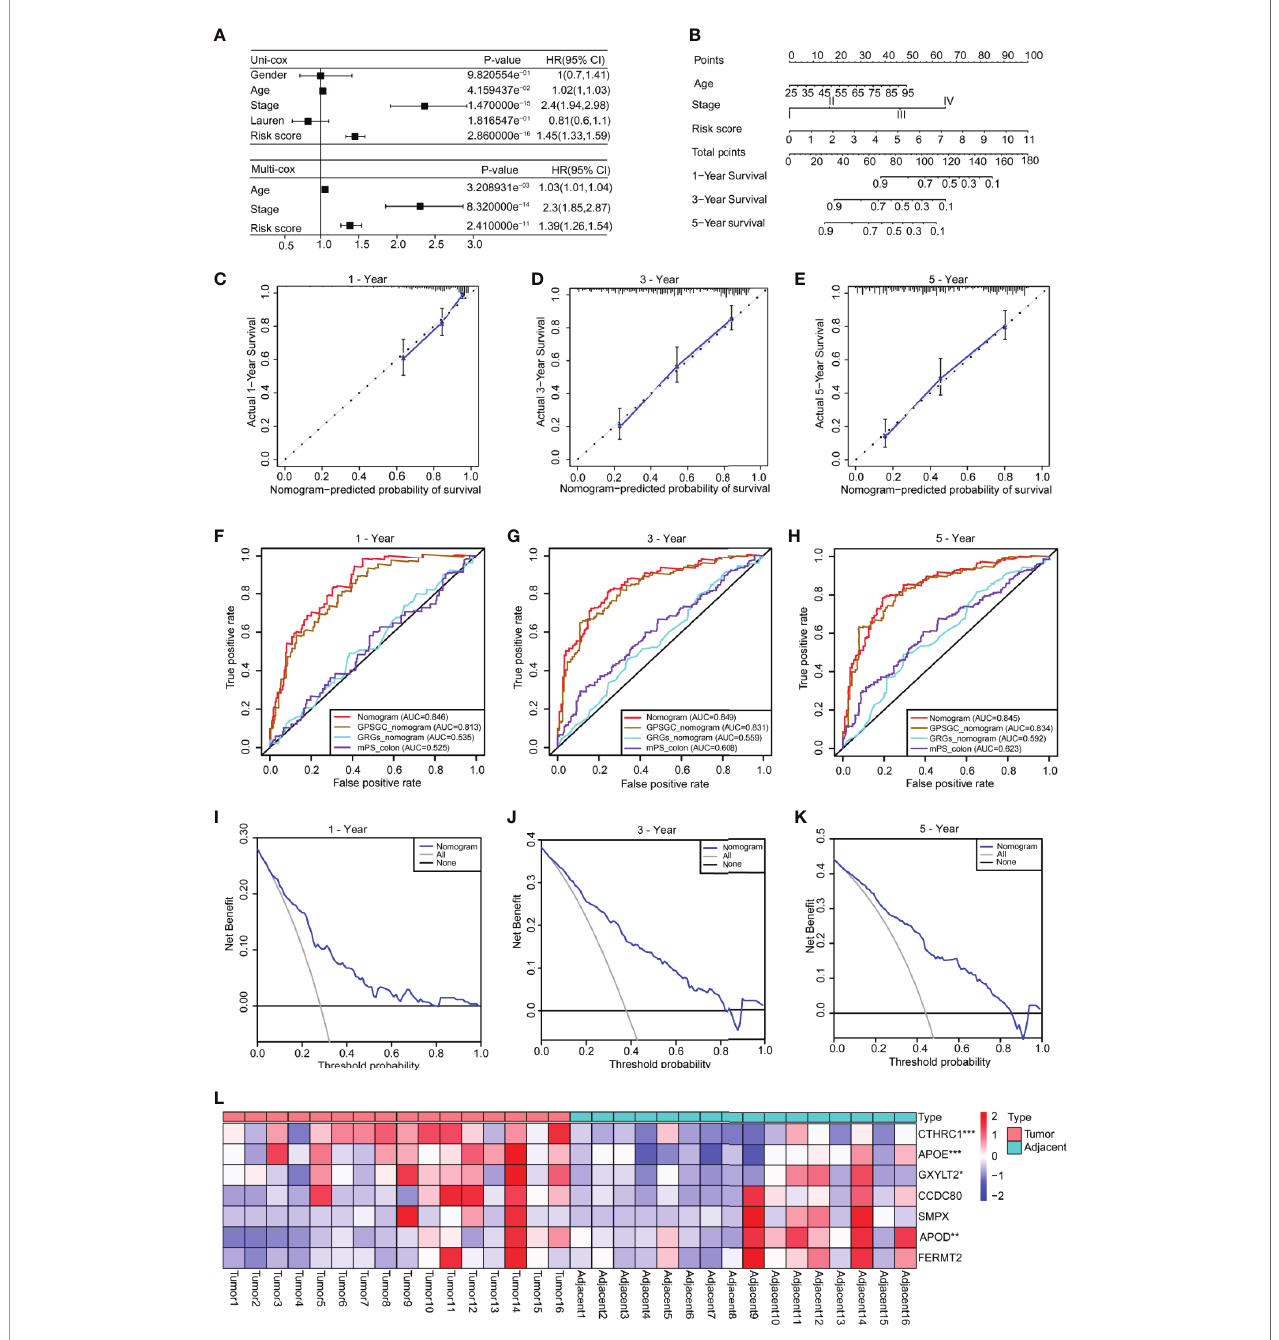
FIGURE 5 | Construction of a nomogram based on the age, stage and risk score. (A) Univariate Cox analysis was used to analyze the clinical factors and risk score, and multivariate analysis was used to analyze the signi fi cant factors from the univariate Cox analysis. (B) A nomogram for clinical diagnosis was constructed based on clinical characteristics and the risk score. (C – E) The calibration plots for predicting recurrence at 1, 3, and 5 years. The X-axis represents the predicted recurrence probability from the nomogram, and the y-axis represents the actual recurrence probability. (F – H) Time-dependent ROC analysis of gastric cancer patient survival was used to evaluate the predictive accuracy of our nomogram and compare it with other previously developed and validated models. The area under the curve (AUC) was calculated and compared (Mann – Whitney tests). (I – K) Decision curve analysis of the nomogram for 1-, 3- and 5-year risk. The x ‐ axis represents the threshold probability, and the y ‐ axis represents the net bene fi t. The black line represents the assumption that no patients died at 1, 3, or 5 years. The gray line represents the assumption that all patients die at 1, 3, or 5 years. The blue dotted line represents the prediction model of the nomogram. All data are from the training set. (L) The heatmap shows the results of real-time fl uorescent quantitative PCR for detecting the mRNA levels of the seven genes in 16 pairs of gastric cancer and adjacent normal tissues (n = 16, paired Student ’ s t-tests). Signi fi cant difference between the two groups: *P < 0.05; **P < 0.01; ***P <